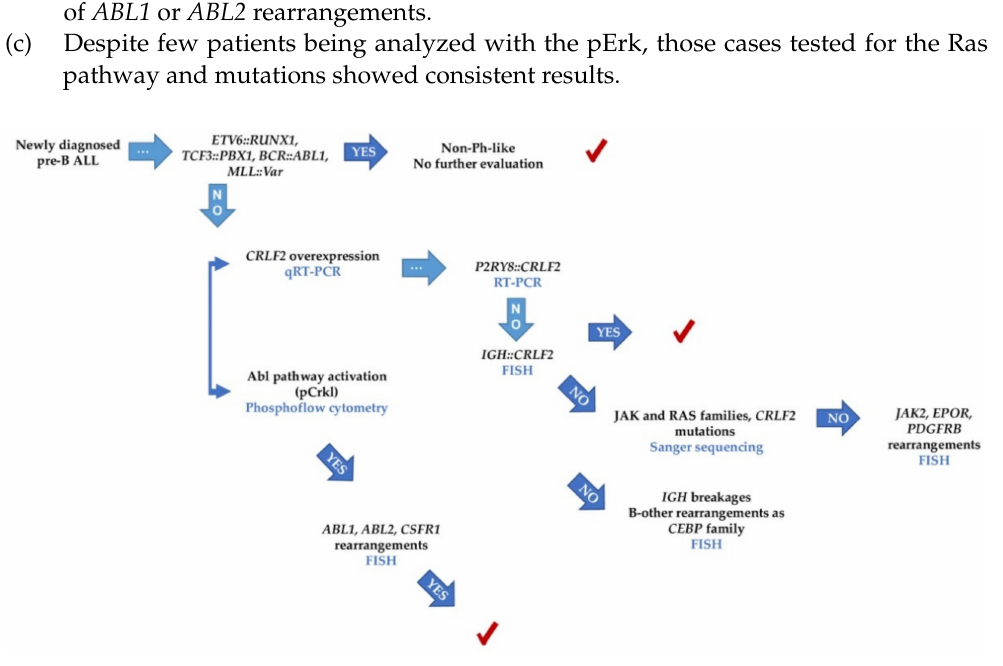
Figure 5. Adapted strategy for Ph-like diagnosis. Proposed testing strategy for the Ph-like subgroup. The analysis comprises the pre-B ALL patients without recurrent gene fusions. (cid:52) = no further evaluation since a final result was